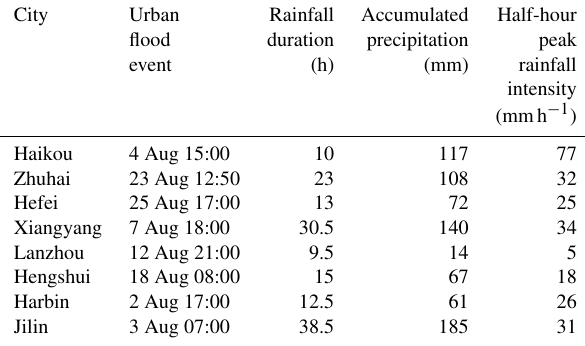
Table 4. An exemplary flooding event in each of the cities. All times are given in the local time